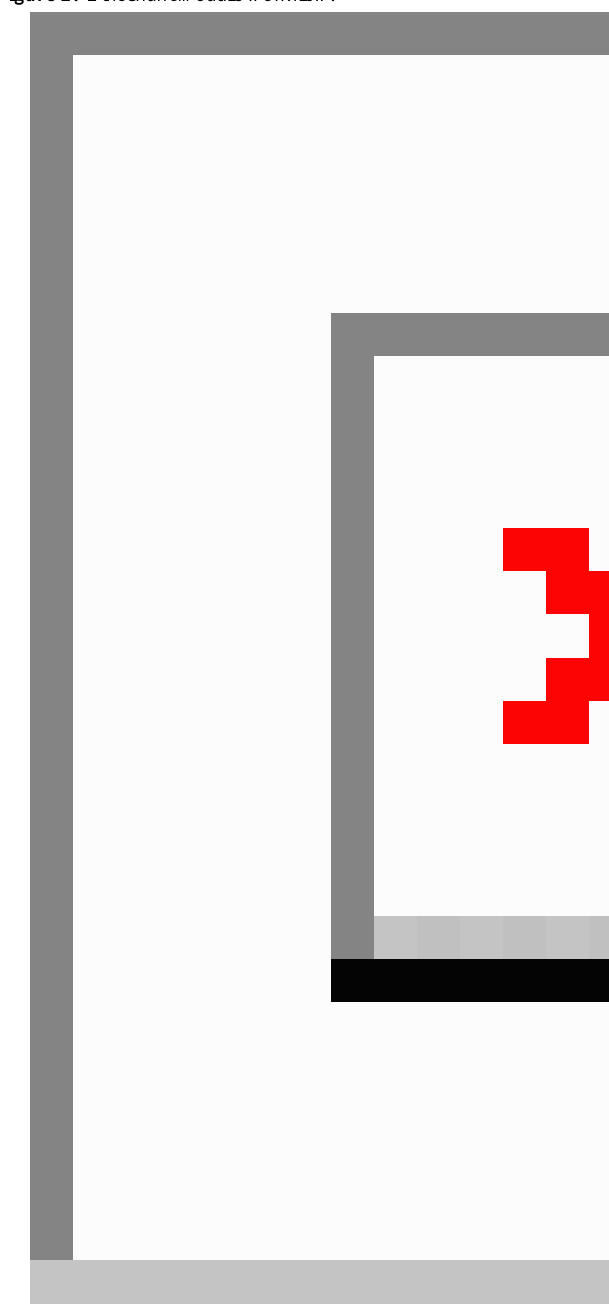
Figure 2. Ethoshunt module